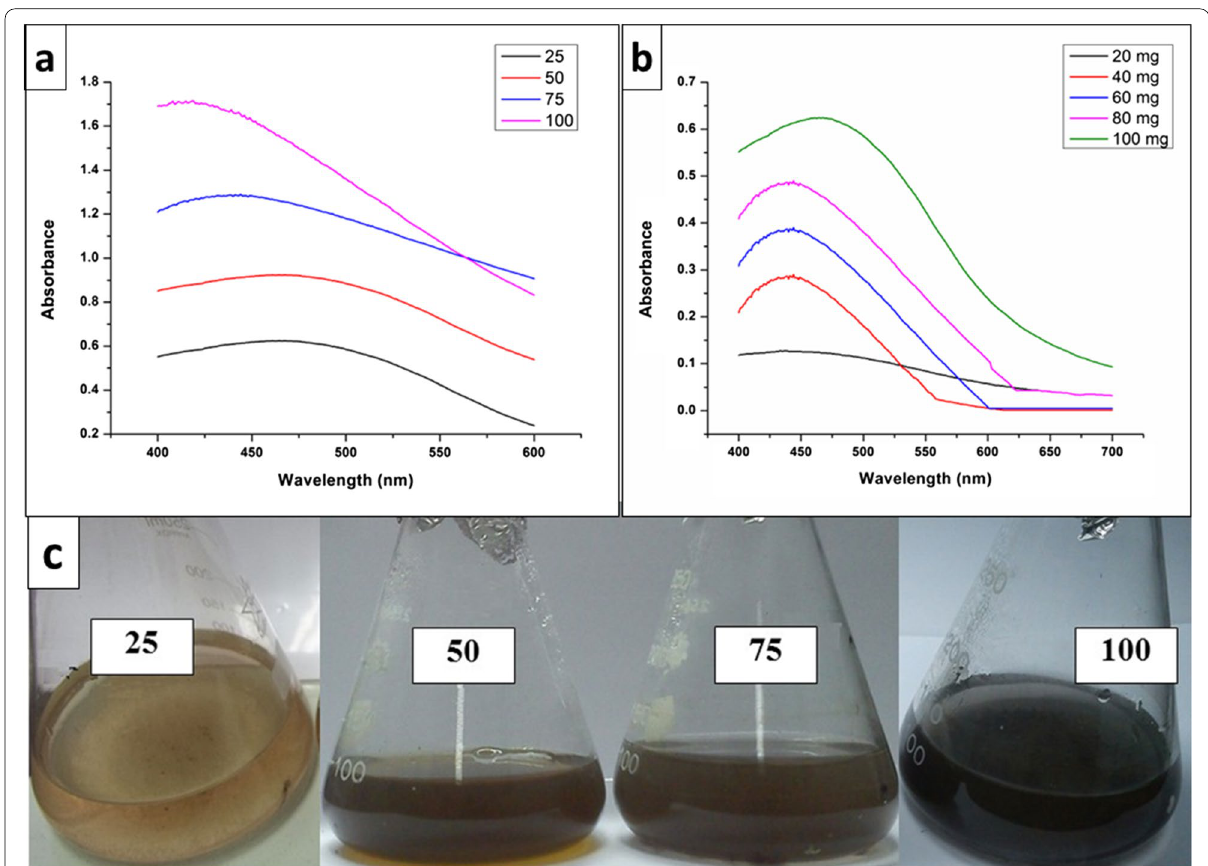
Fig. 4 Biosynthesis of Ag NPs by Streptomyces sp. U13. UV–Vis spectra at different Ag + concentration (25, 50, 75 and 100 mg) ( a ) UV–Vis spectra at different biomass weights (20, 40, 60, 80 and 100 mg dry weight equivalent) ( b ) and image of colour change during biosynthesis process at different Ag + mg/l concentration ( c